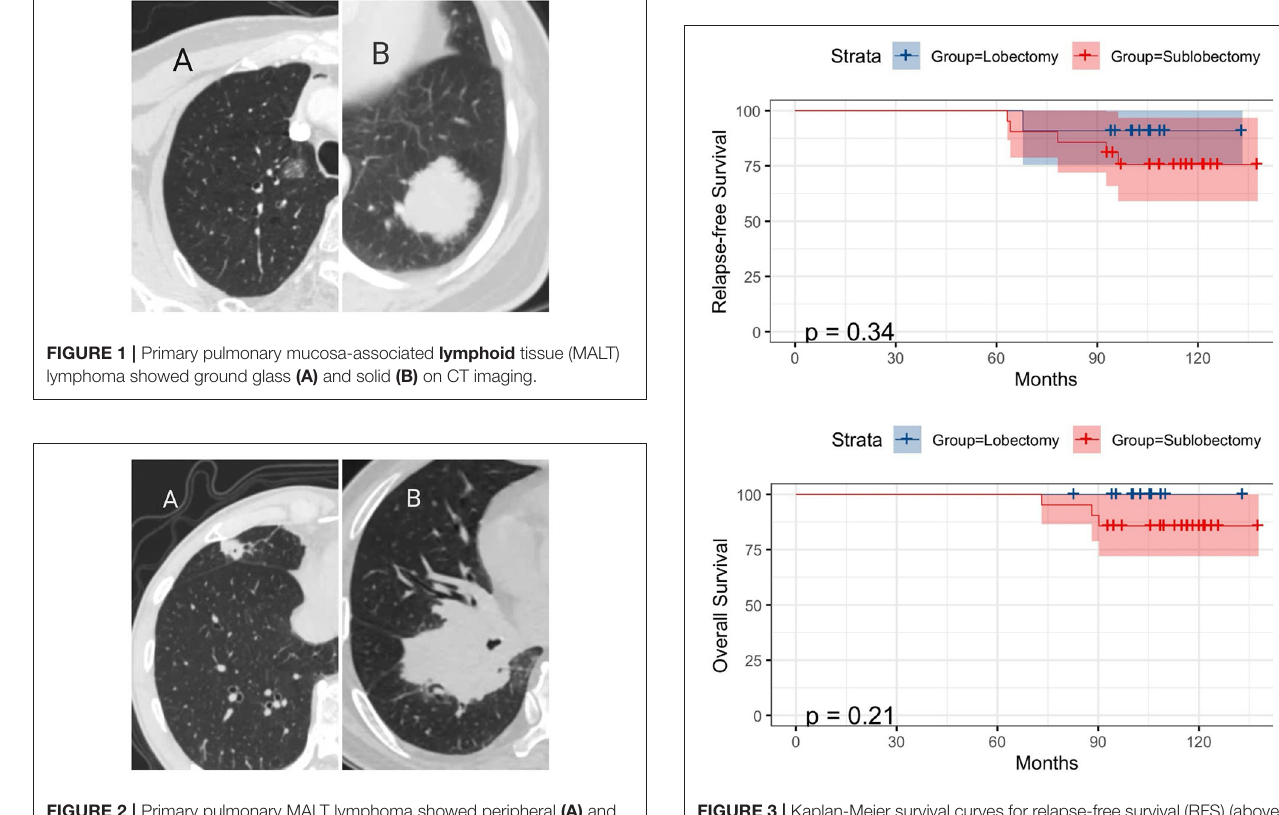
FIGURE 2 | Primary pulmonary MALT lymphoma showed peripheral (A) and central (B) types on CT Imaging.